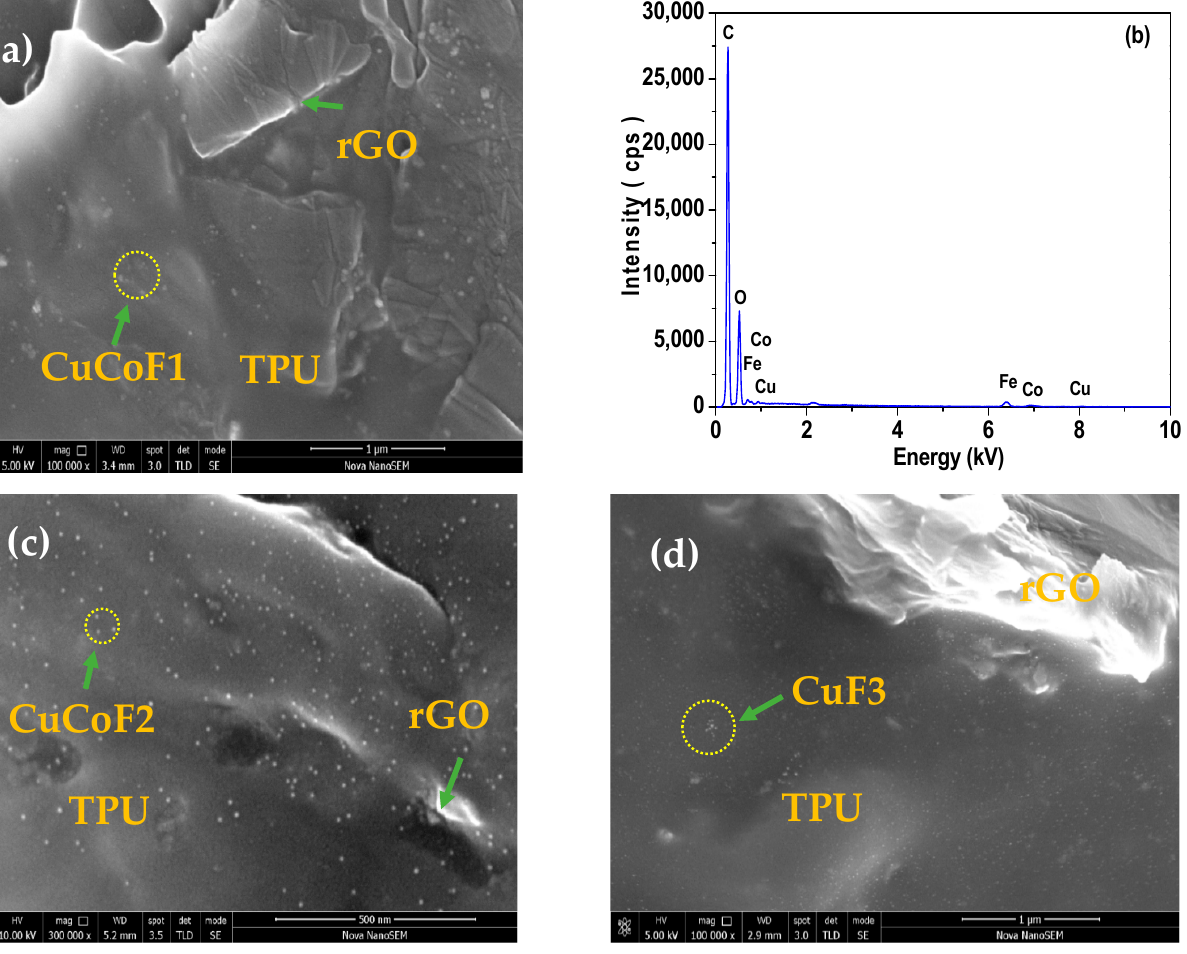
Figure 5. ( a ) FE ‐ SEM image of CuCoF1 ‐ rGO ‐ TPU, ( b ) EDX pattern of CuCoF1 ‐ rGO ‐ TPU, ( c ) FE ‐ SEM Figure 5. ( a ) FE-SEM image of CuCoF1-rGO-TPU, ( b ) EDX pattern of CuCoF1-rGO-TPU, ( c ) FE-SEM image of CuCoF2 ‐ rGO ‐ TPU, and ( d ) FE ‐ SEM image of CuF3 ‐ rGO ‐ TPU. image of CuCoF2-rGO-TPU, and ( d ) FE-SEM image of